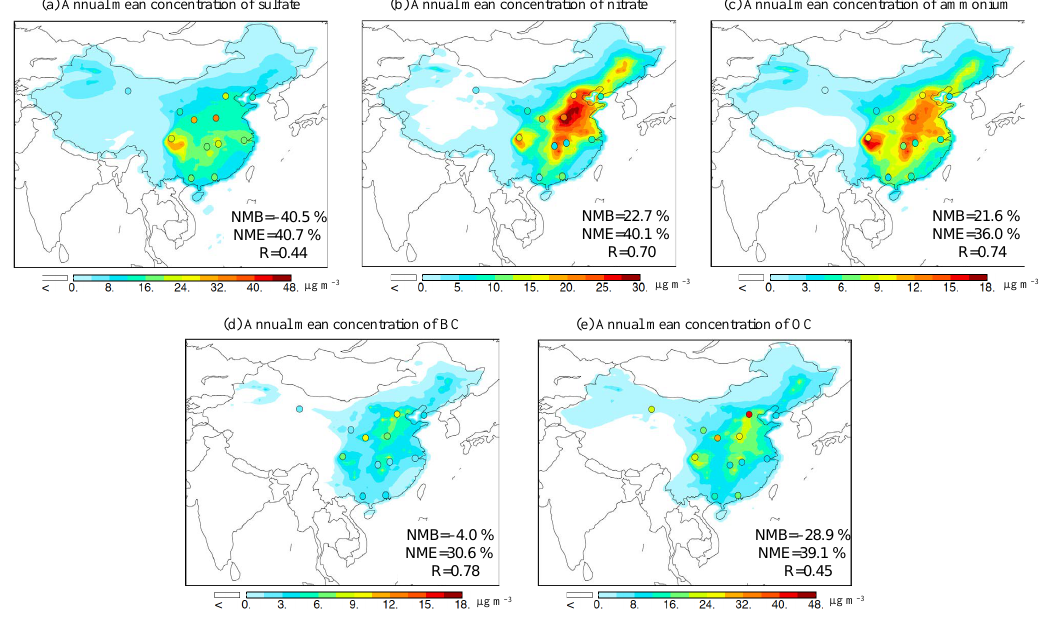
Figure 5. Simulated and observed PM 2 . 5 composition in